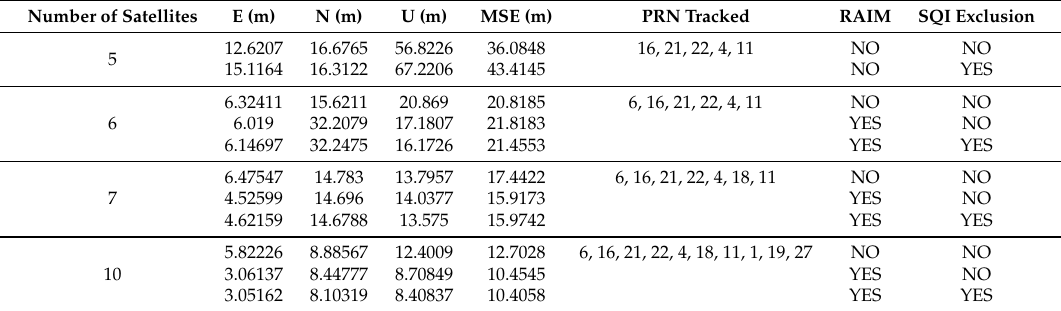
Table 5. Results for the scenario 1 with SQI thres = 0.7 and no penalty